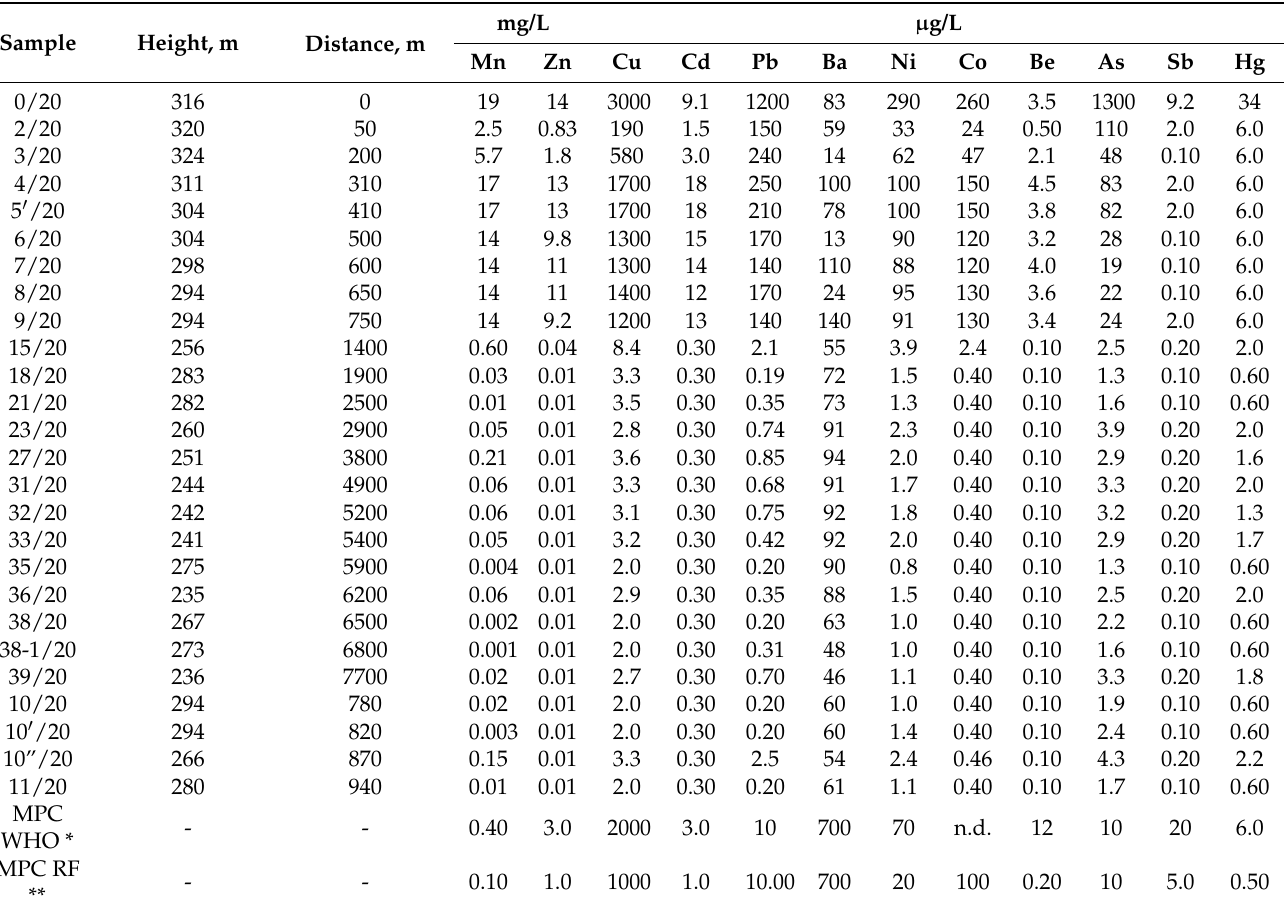
Table 3. Trace element composition of surface water in the drainage at the foot of the dump, in the drainage valley, and in the river upstream and downstream the drainage inflow.